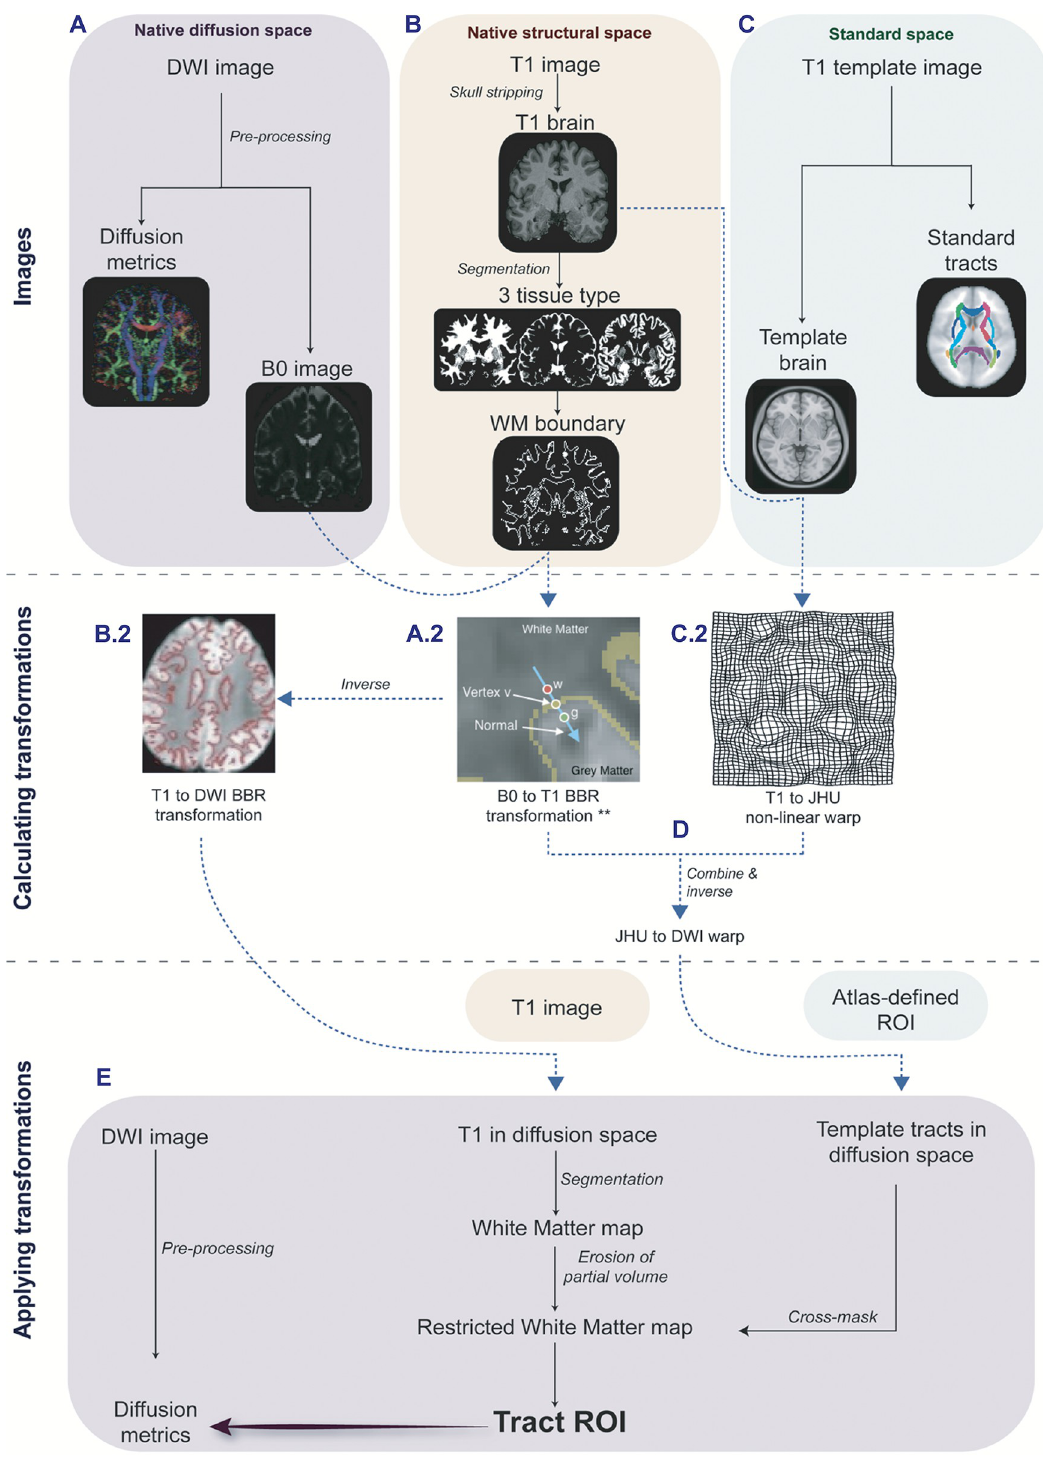
Fig 2. Overview of the pipeline. DWI images are pre-processed individually. 3D T1-weighted images are segmented, the mask of the WM boundary is estimated and used for a BBR of the diffusion image to the T1 image. Non-linear registration is estimated to move the T1 image to a pre-defined template space. The BBR matrix and the non-linear warp are then combined and reversed to estimate a transformation from the standard template to the individual diffusion image. The reverse BBR matrix is applied to the original T1-image, resulting in an inter-modality registration of the T1 to the DWI image. In the last steps, once all three images are